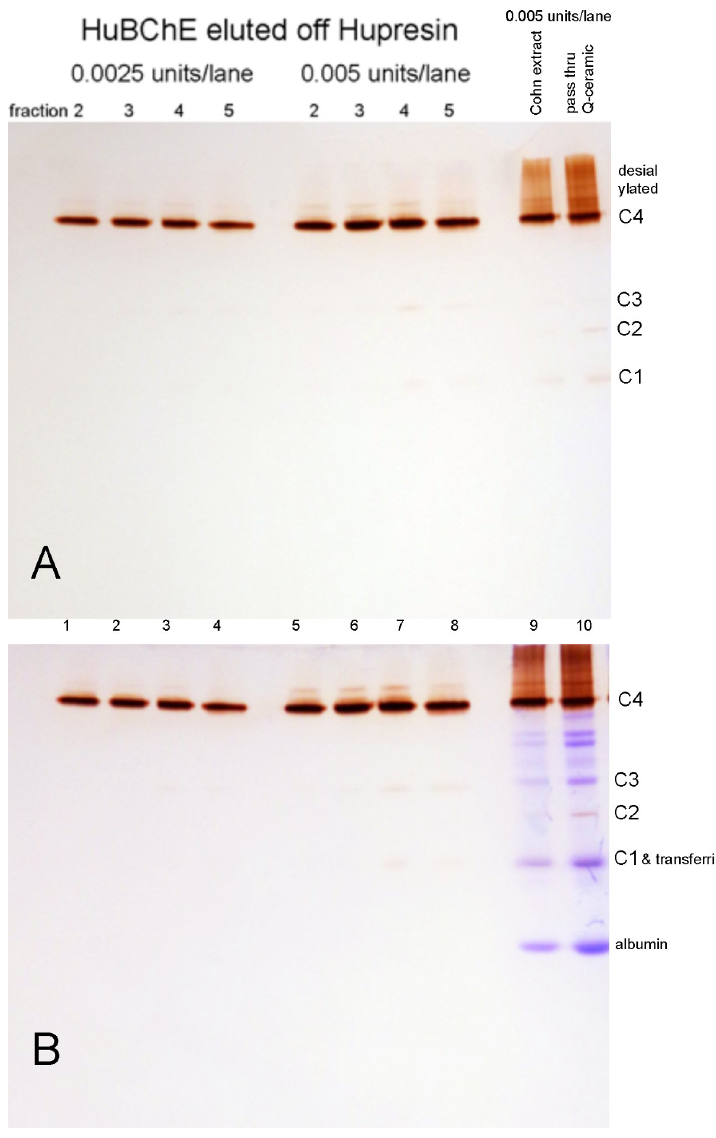
Fig 9. Nondenaturing polyacrylamide gradient gel stained for BChE activity (A) and counterstained with Coomassie blue (B). HuBChE eluted from Hupresin (lanes 1–8) consists predominantly of tetramers (C4). Desialylated HuBChE in the Cohn extract and the Q-Ceramic pass-thru migrates near the top of the gel in a broad band (lanes 9 and 10). Cohn paste extract (lane 9) contains partly desialylated HuBChE. The desialylated HuBChE did not bind to Q-Ceramic at pH 4.5, but passed through as visualized by the intense staining for the Q-Ceramic pass through (lane 10). Faint bands of activity are best seen in panel A where C1 is the HuBChE monomer, C2 is an albumin-HuBChE dimer [25], and C3 is a HuBChE dimer. The major band of HuBChE activity is the tetramer C4. The gel counterstained with Coomassie blue (panel B) shows the same pattern of blue bands in lanes 9 and 10. This means the major protein contaminants in the Cohn extract (lane 9) pass through Q-Ceramic without binding (lane